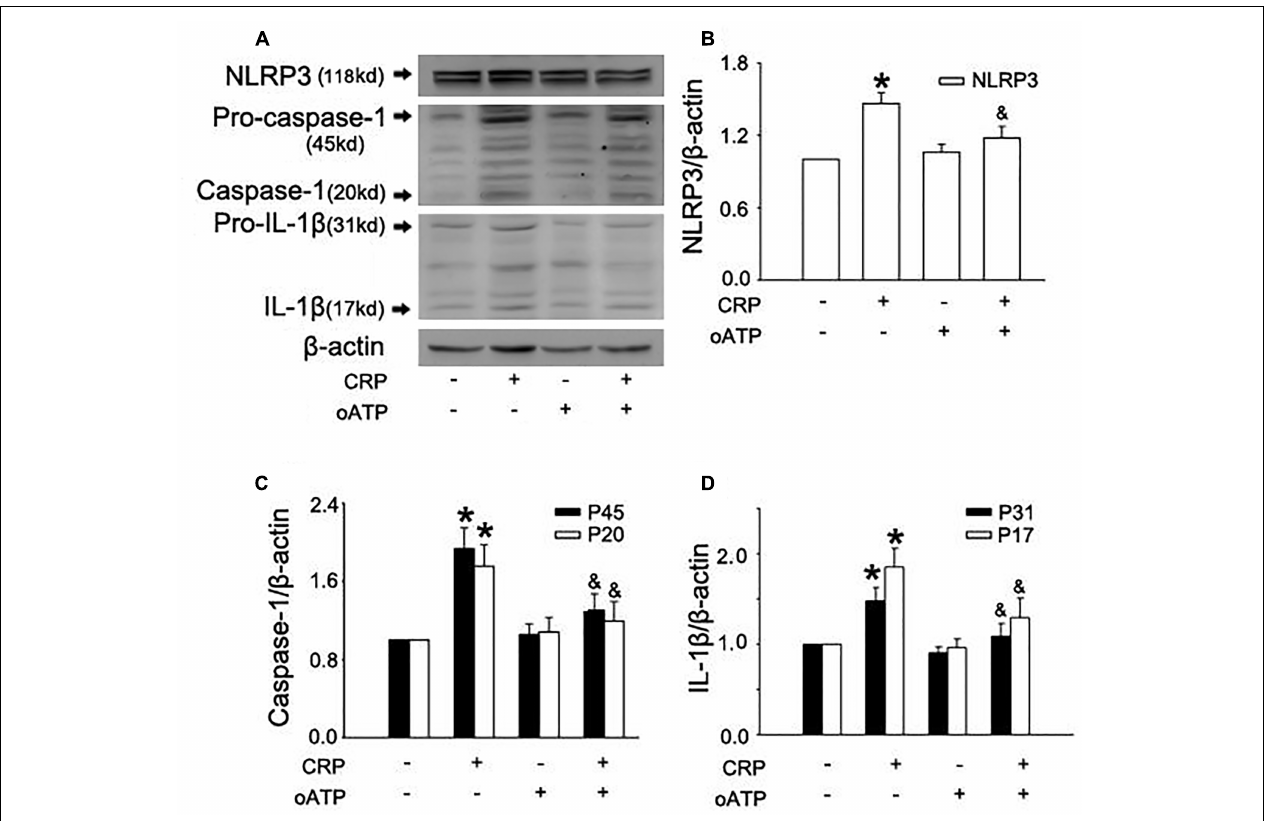
FIGURE 4 | Purinergic receptor signaling is implicated in CRP-induced NLRP3 inflammasome activation. HUVECs were incubated with 100 µ mol/L oATP for 1 h, and then were treated in the absence or presence of 20 µ g/mL CRP for 24 h. (A) Representative Western blots showing the expression of NLRP3, pro-caspase-1, caspase-1, pro-IL-1 β , and IL-1 β . (B–D) Summary bar graphs showing the expression of proteins. ∗ P < 0.05 vs. Ctr; & P < 0.05 vs. CRP; n =